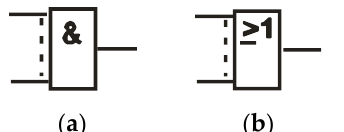
Figure 1. Basic symbols used to create a fault tree: ( a ) AND gate, ( b ) OR gate [16,22,23]. The gates represent two logical operators: “OR” and “AND.” The OR gate indicates